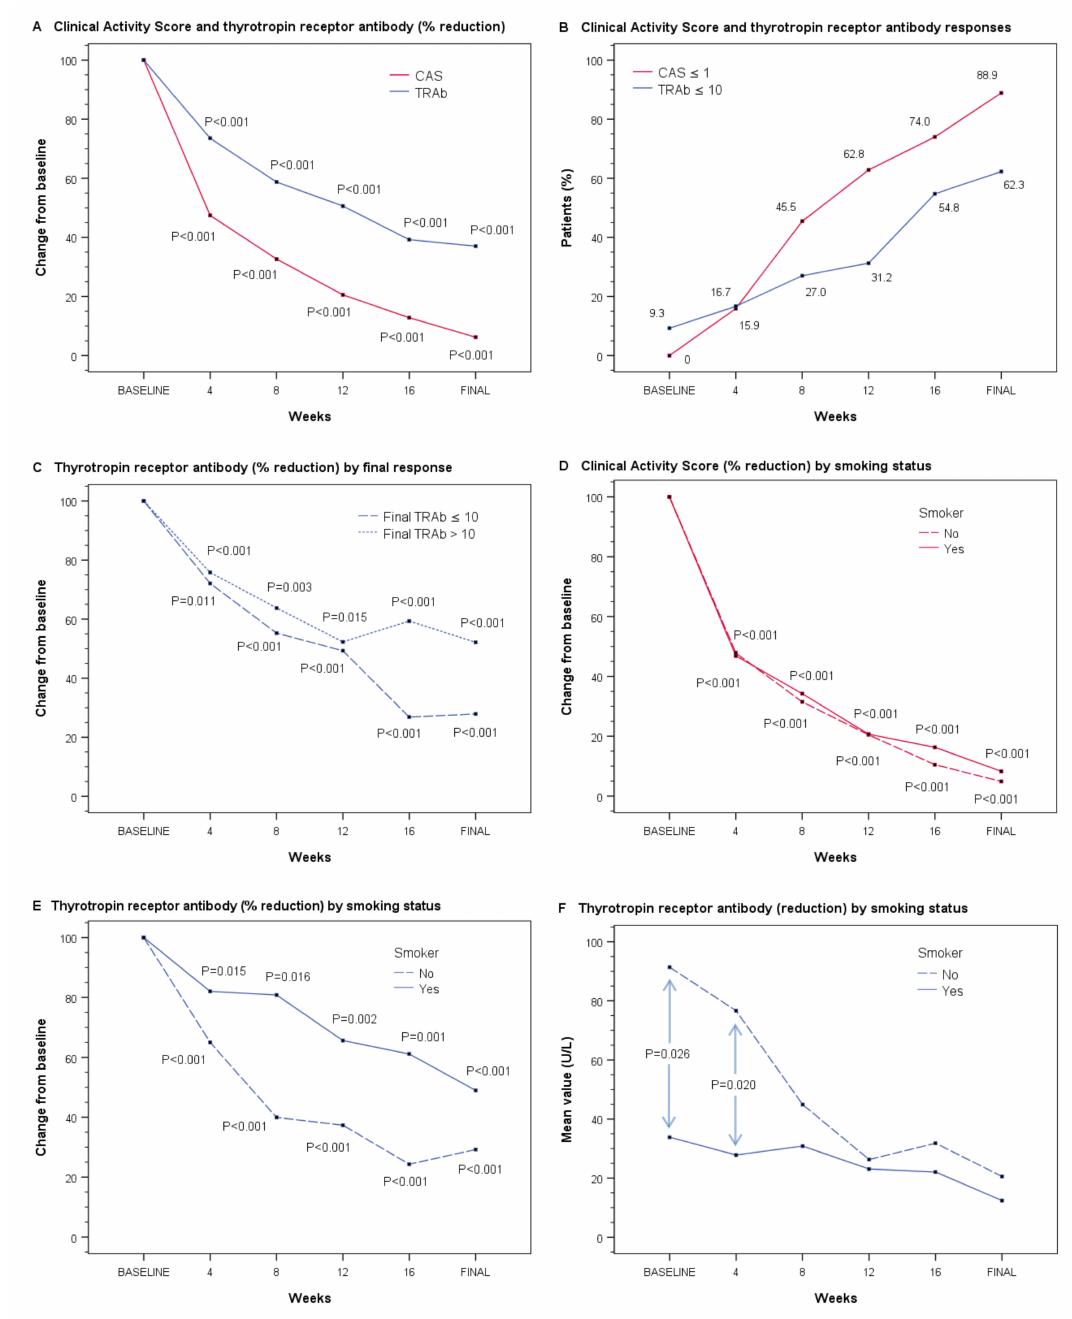
Figure 1. Main effectiveness outcomes during the course of the treatment with tocilizumab. ( A ) Panel A shows the rate of reduction in the Clinical Activity Score (CAS) and thyrotropin receptor antibody (TRAb) level as the mean percentage changes from baseline (mean relative percentage values are shown to facilitate interpretation, while p -values were calculated with the Wilcoxon test using the medians of the absolute values of the measurements). CAS and TRAb values correspond to measurements at baseline and at one month after each treatment dose. ( B ) Panel B shows the responses with regard to CAS (defined as CAS ≤ 1) and TRAb (defined as TRAb ≤ 10 U/L) throughout the treatment period (CAS and TRAb responses by smoking status can be seen in Figure S1A,B). ( C ) Panel C shows the mean percentage change in TRAb from baseline according to the final TRAb response. ( D , E ) Panels D and E show the rate of reduction in CAS and TRAb, respectively, according to smoking status. ( F ) Panel F shows the mean TRAb levels in smokers and non-smokers; comparisons between groups were performed with the Mann–Whitney U test. (The mean CAS reduction by smoking status can be seen in Figure S1C). The p -values shown in panels C , D , and E were calculated with the Wilcoxon test using the medians of the absolute values of the